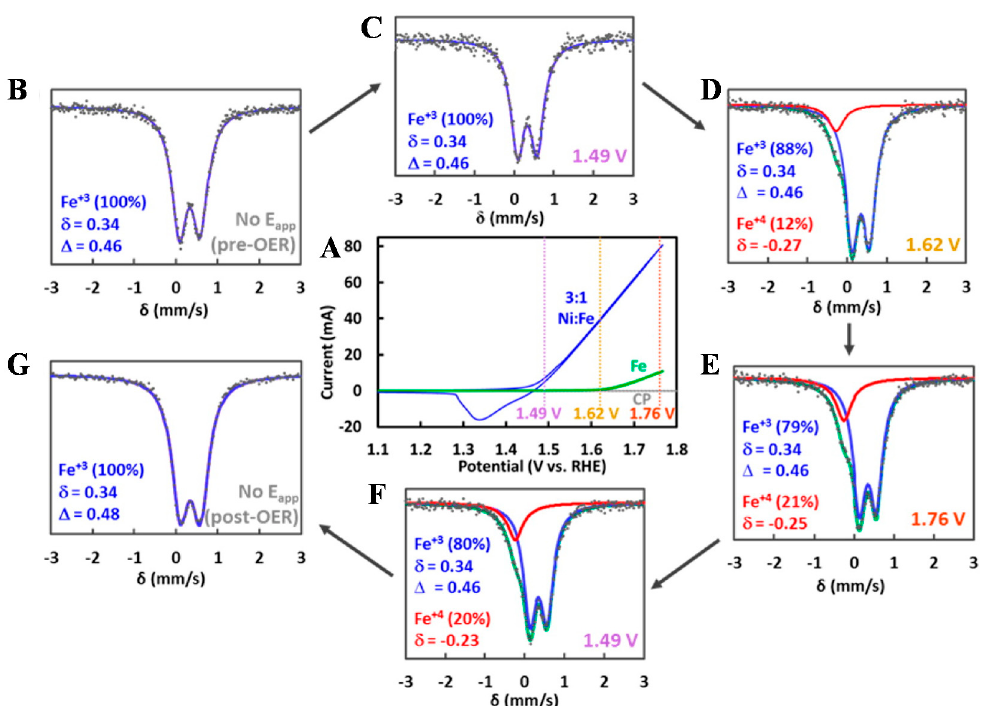
Figure 3. ( A ) CV curves of NiFe layered oxyhydroxide electrocatalysts used for the operando experiments with ( B , G ) Mössbauer spectra collected at open circuit (gray), at ( C , F ) 1.49 V (purple), ( D ) 1.62 V (yellow), and ( E ) 1.76 V (red). CV data were recorded in the Mössbauer-electrochemical cell with a scan rate of 25 mV/s prior to Mössbauer measurements [121]. Copyright © 2015 American Chemical Society.